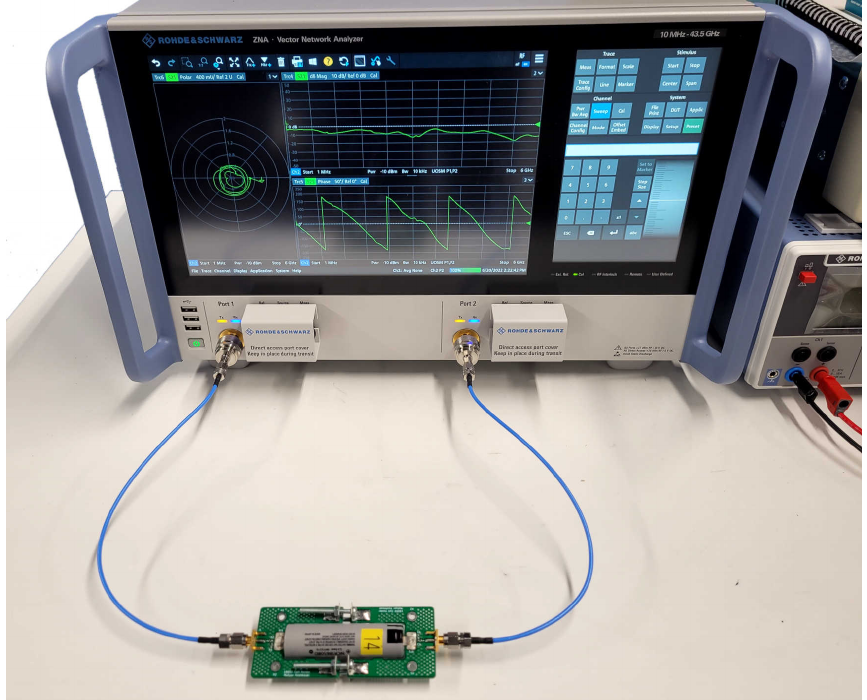
Figure 1. Photo of the Li-ion cell connected to the VNA. The Li-ion cell is clamped within the bespoke cell holder as described in Section 2.3.